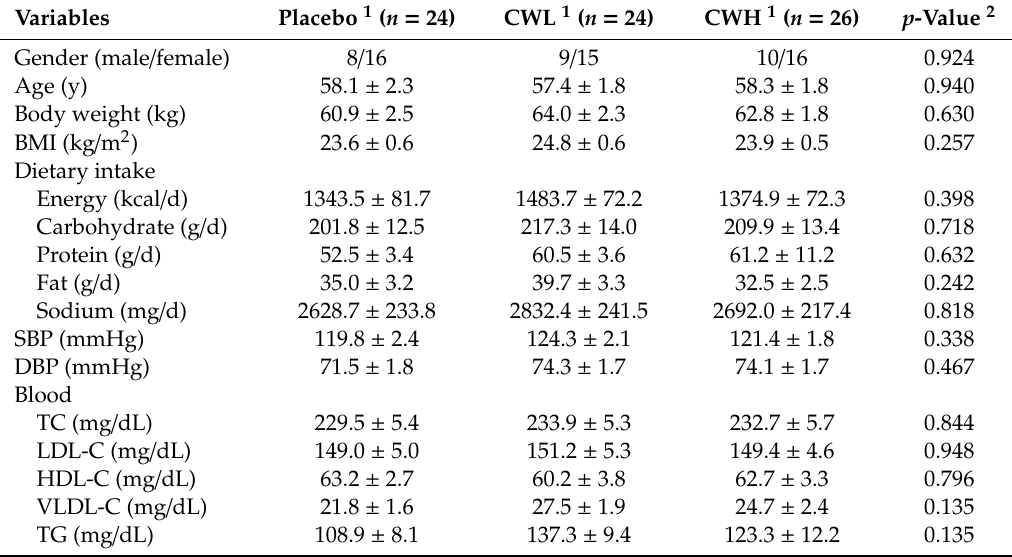
Table 1. Baseline characteristics of the 74 study